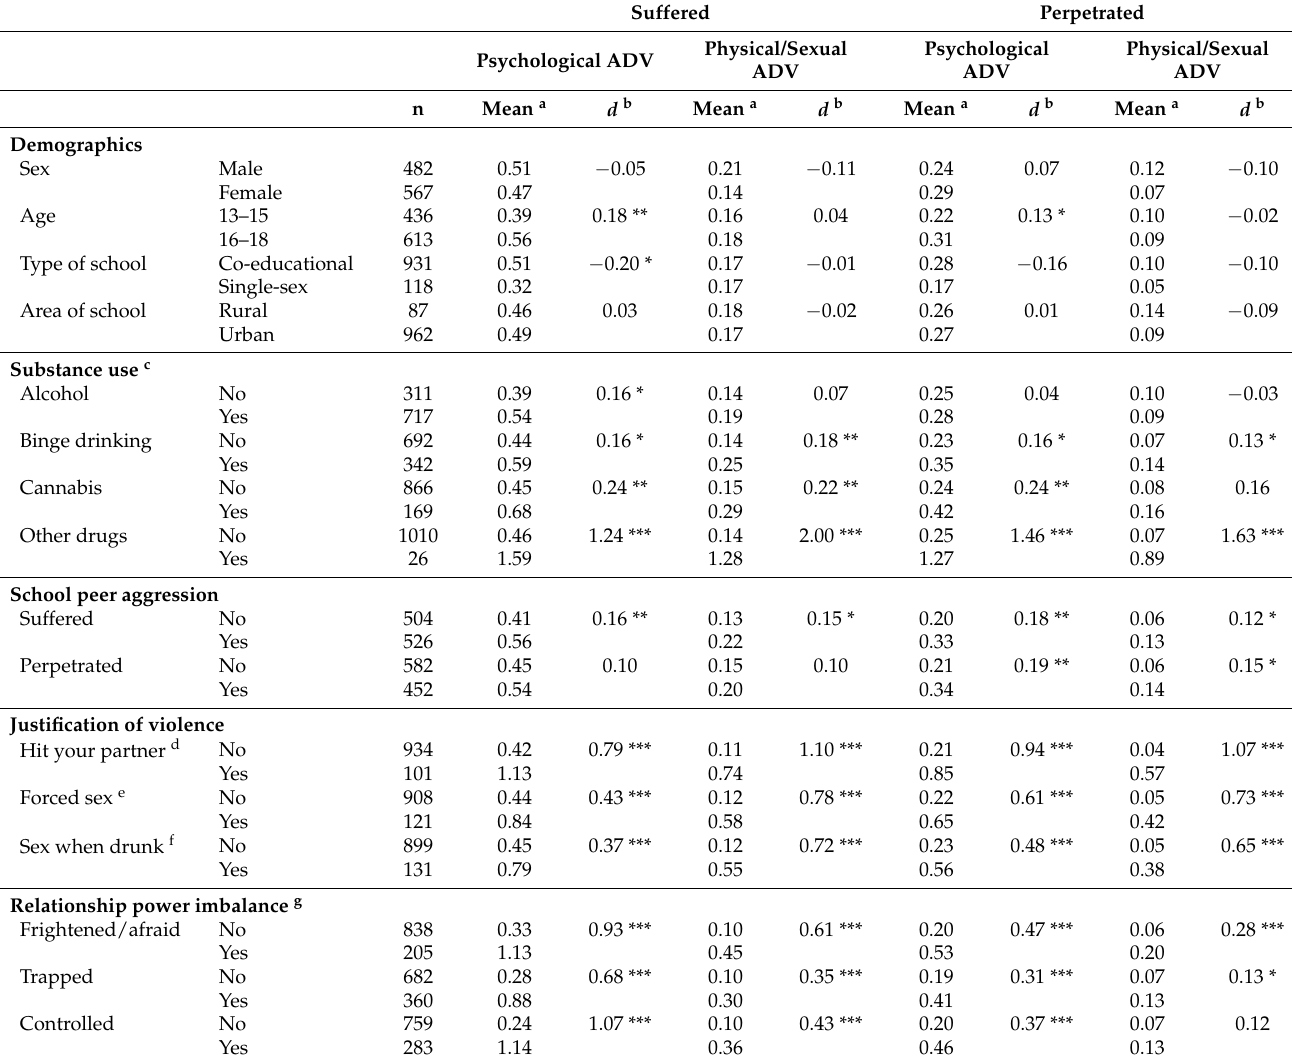
Table 3. Differences in the adolescent dating violence (ADV) subscales across groups defined by some predictor variables.